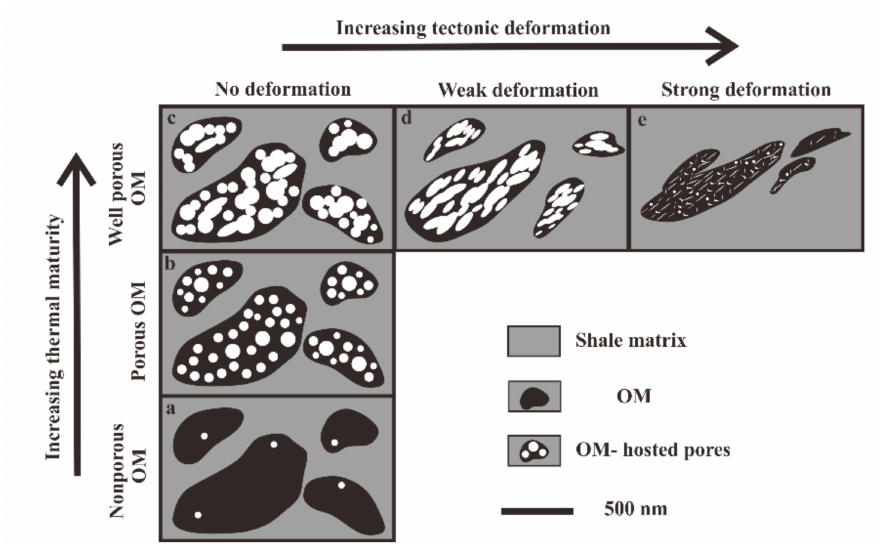
Figure 8. Schematic diagrams showing OM pore evolution of organic-rich shales during both thermal maturity ( a – c ) and tectonic deformation ( c – e ).